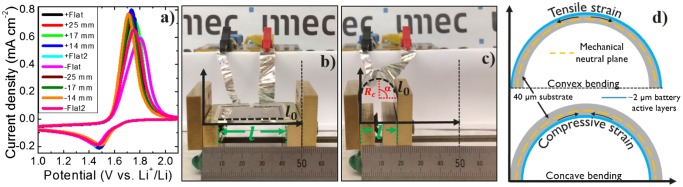
(a) Cyclic voltammograms at a scanning rate of 10 mV s−1 for a thin-film all-solid-state flexible battery stack based on Li4Ti5O12/LiPON/Li at different bending states. Photographs of the flexible battery in the bending characterization apparatus on (b) a flat state (R
c = ∞) and c) with curvature radius R
c = 8.5 mm. (d) Schematic representation of the thin-film stack in convex and compressive bending state showing the mechanically neutral plane for both cases and the tensile and compressive strains.